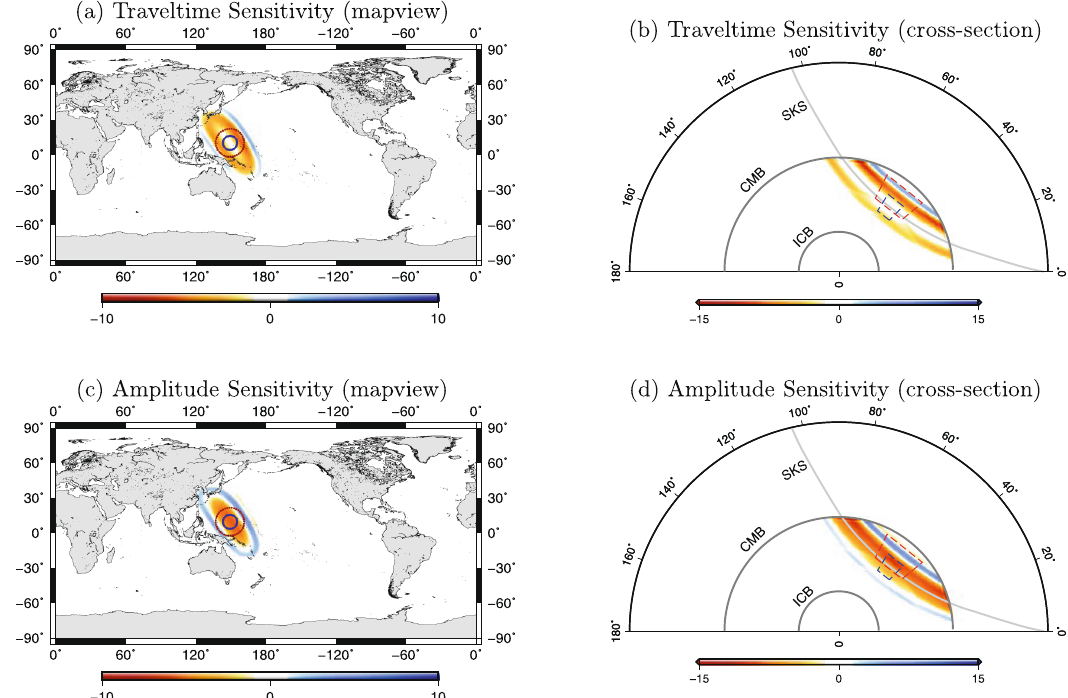
Fig. 5 SKS fi nite-frequency sensitivity and outer core anomalies used in modeling. a and b are map view and cross-section view of the SKS travel time fi nite-frequency sensitivity at a period of 30 s, calculated for the SKS wave at station ULN (turning point latitude 9.96 ∘ N). The map views are plotted at the turning depth of the SKS wave. c and d are the same as ( a ) and ( b ) but for the amplitude of the SKS wave. The wavespeed anomalies used in Fig. 6 are also plotted here for reference. The anomalies are axis symmetrical with a cylindrical (conical) shape. The small anomaly (blue) has a radius of 6 ∘ and a depth extent of 600 km centered on the ray path. The large anomaly (red) has a radius of 12 ∘ and a depth extent of 800 km above the geometrical